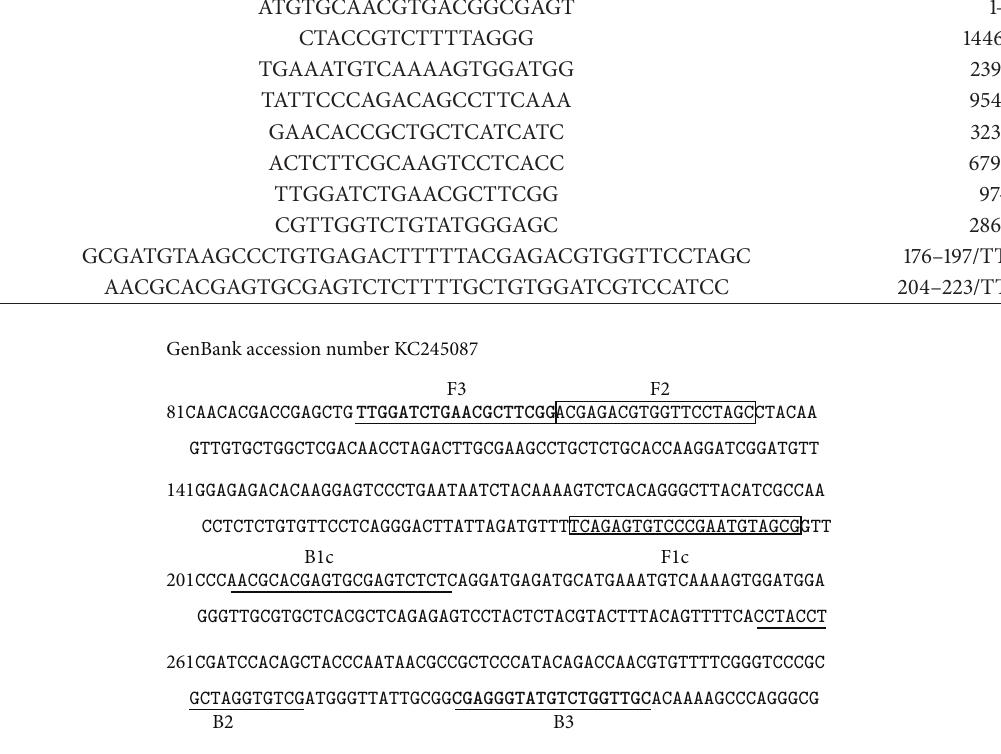
Figure 1: The nucleotide sequence of partial CyHV-2 DNA helicase gene used to design inner and outer primers for